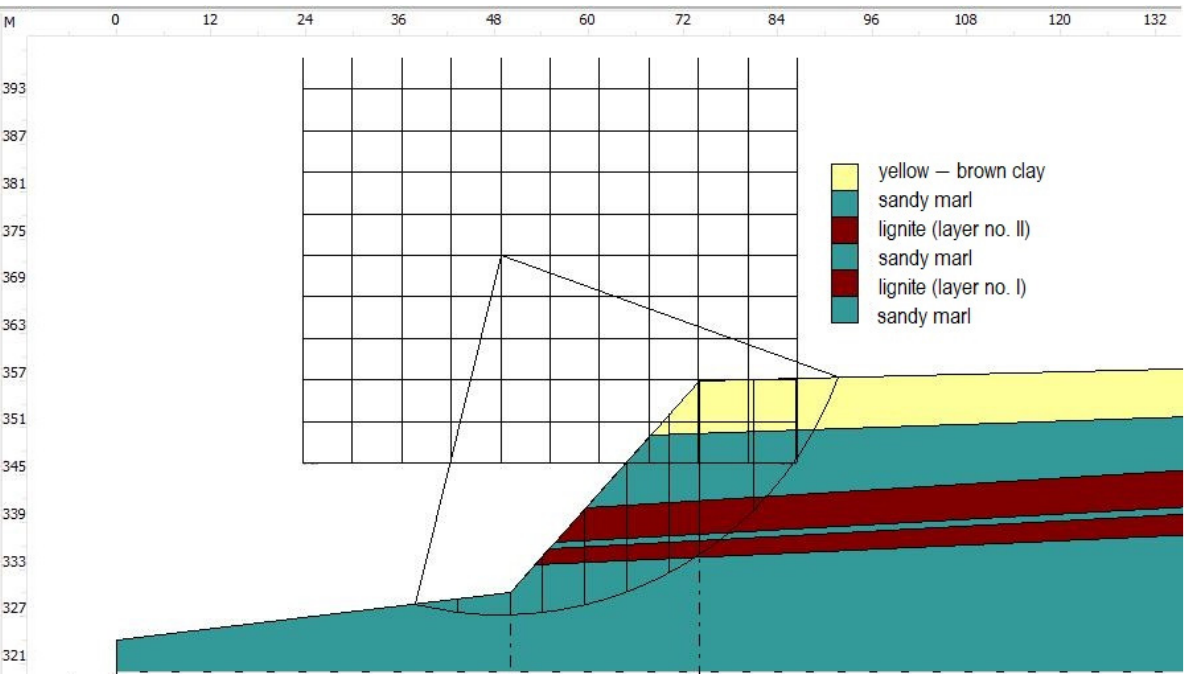
Figure 8. Section L2, F s1 = 1.22 (December 2021).